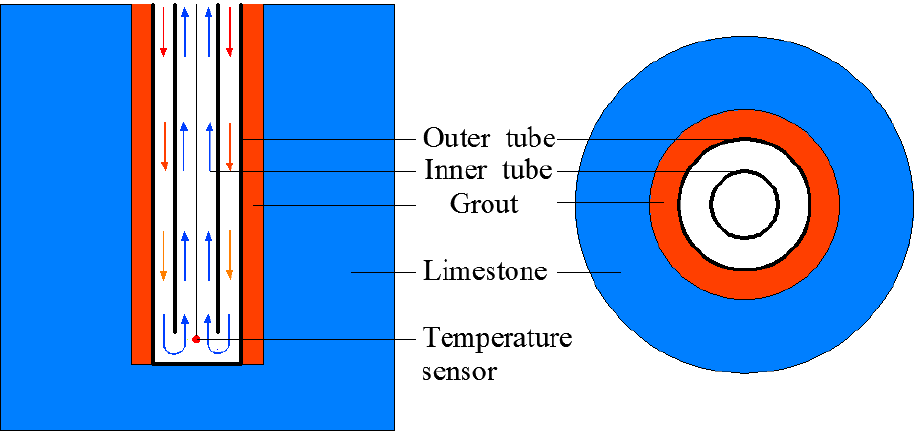
Figure 7. Numerical model diagram of coaxial borehole heat exchanger (CBHE).